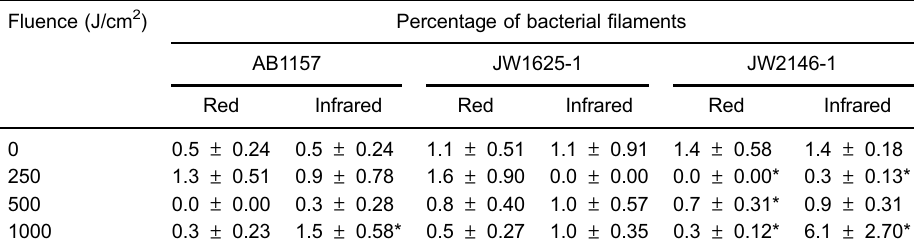
Table 5. Bacterial fi lament percentages in stationary E. coli cultures exposed to low-intensity red and infrared lasers. Fluence (J/cm 2 )